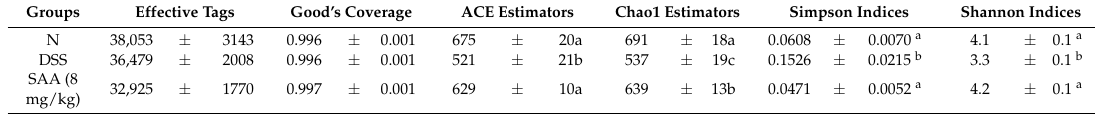
Table 2. Diversity indices obtained from the pyrosequencing results 1